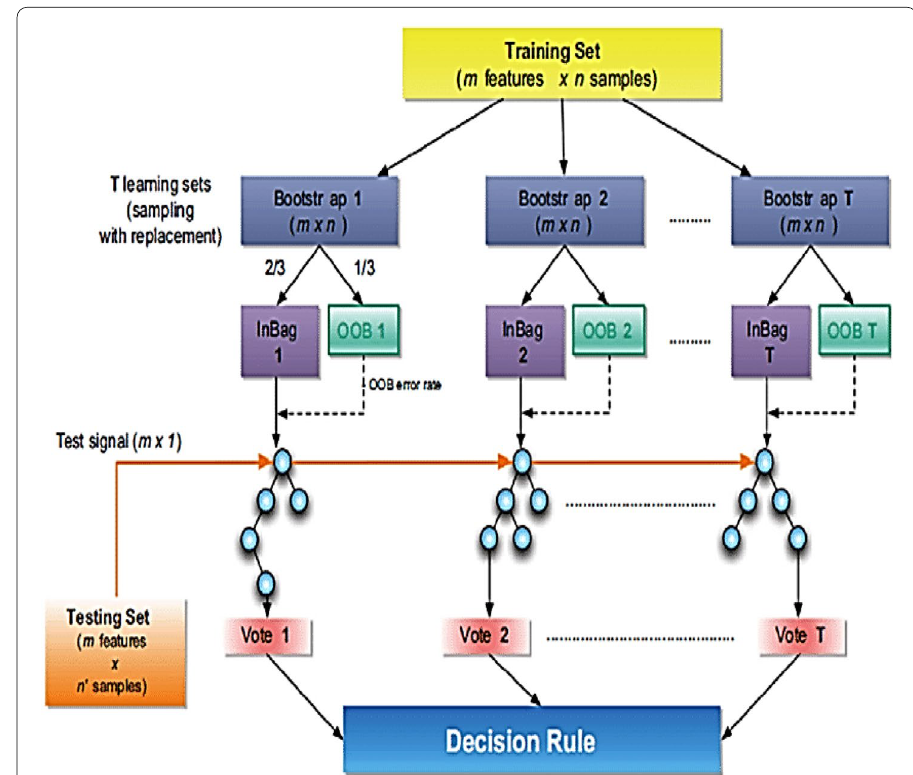
Fig. 13 The description of all process of the used random forest